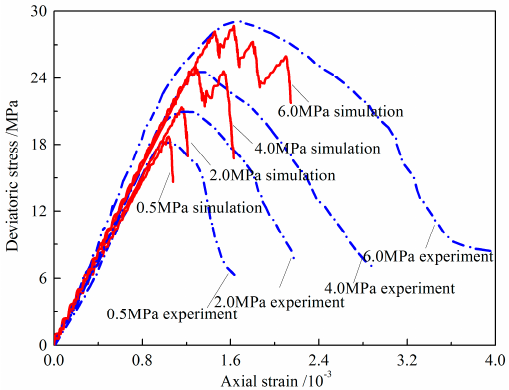
Figure 13. Comparison between experimental and numerical deviation stress versus axial strain curves.